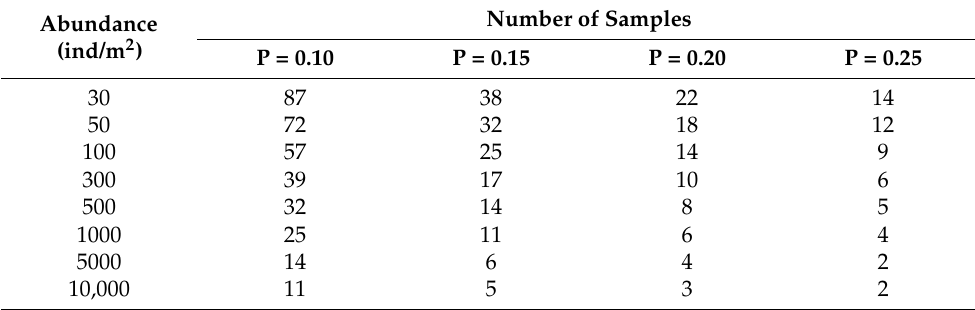
Figure 7. Estimation of the sampling effort (number of samples) in relation to the desired level of precision ( p values are given aside of each curve) and the expected mean abundance of benthic macroinvertebrates (ind/m 2 ). Table 4. Number of samples required for a given abundance of benthic macroinvertebrates (ind/m 2 ) to attain the desired level of precision